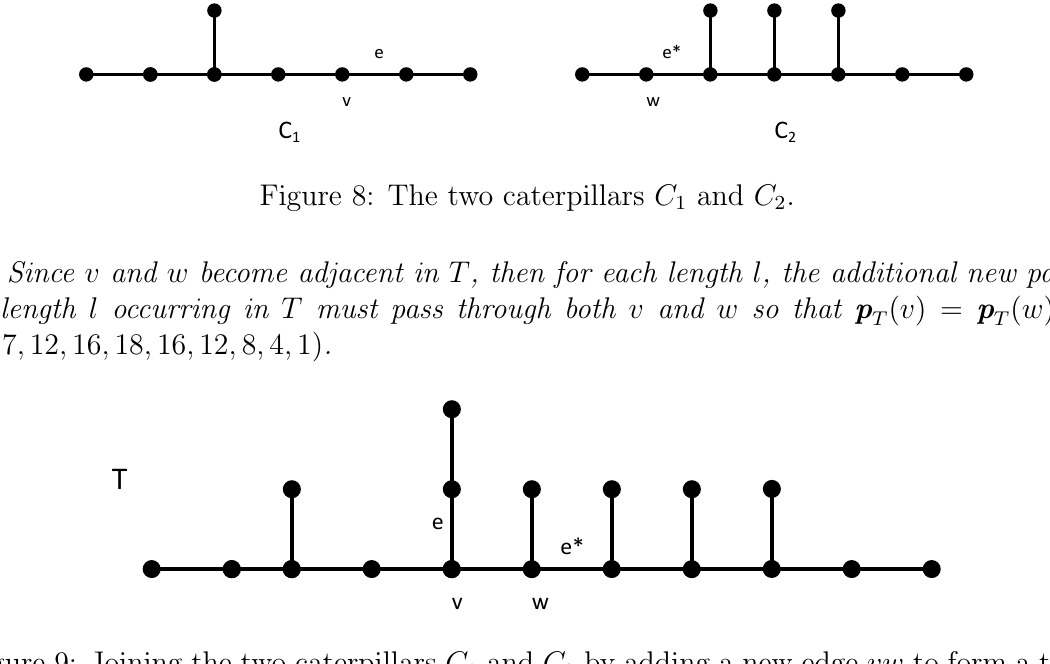
Figure 9: Joining the two caterpillars 𝐶 tree 𝑇 .